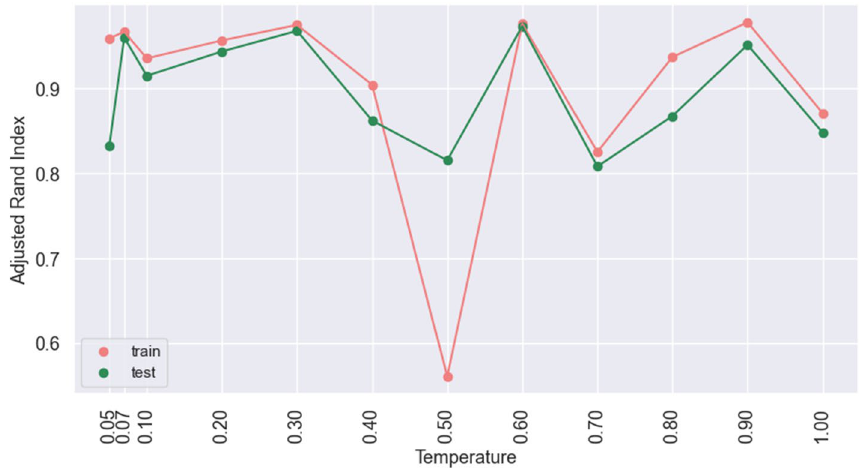
Figure 6. Adjusted Rand Index on the model trained on npos_2WellGraph with different temperature values of the contrastive loss. The red.